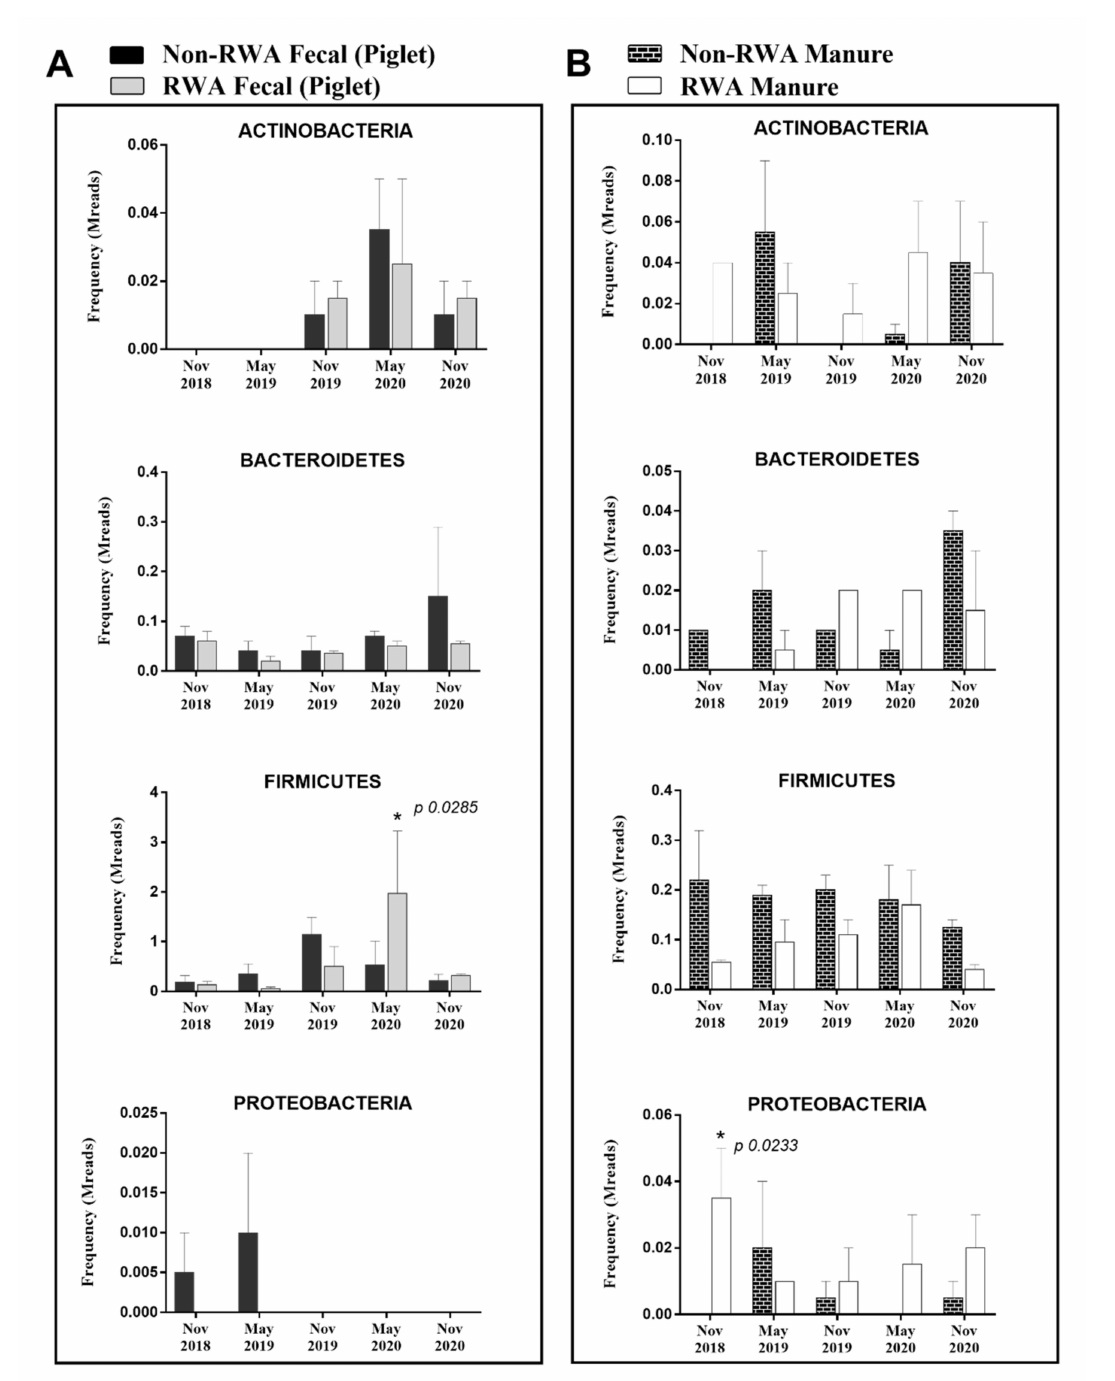
Figure 3. Pathogen prevalence in piglet feces ( A ) and barn manure ( B ) samples. The stacked bars represent the averaged frequency of the pathogens obtained from all bacteriome phyla by extracting subsets of human and/or animal RG2